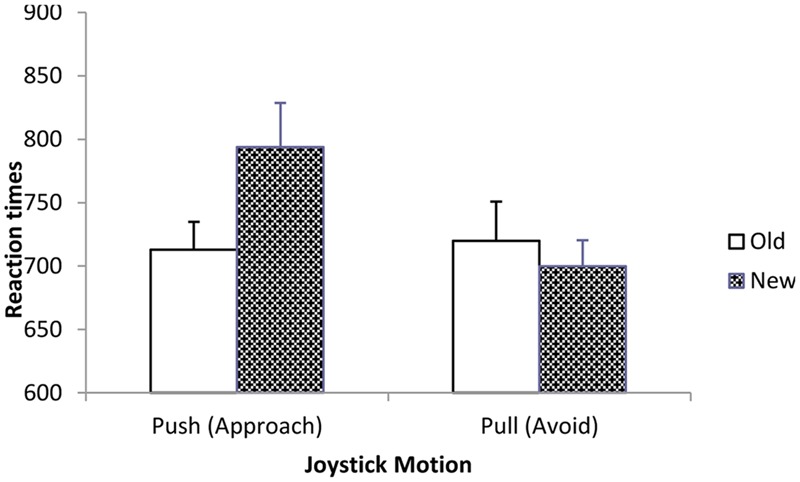
Reaction times to perform pushing and pulling motions in response to familiar (Old) and novel (New) targets (Experiment 1).